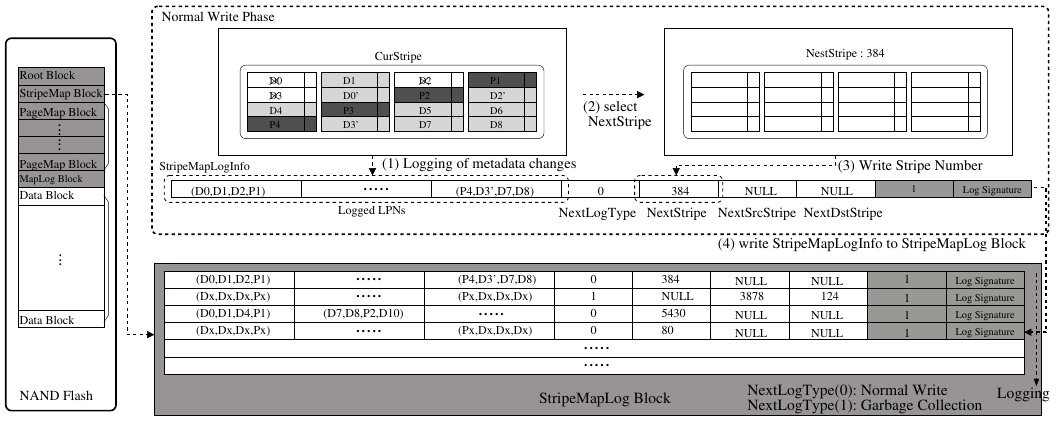
Figure 6. Stripe map log operations for RAID and parity